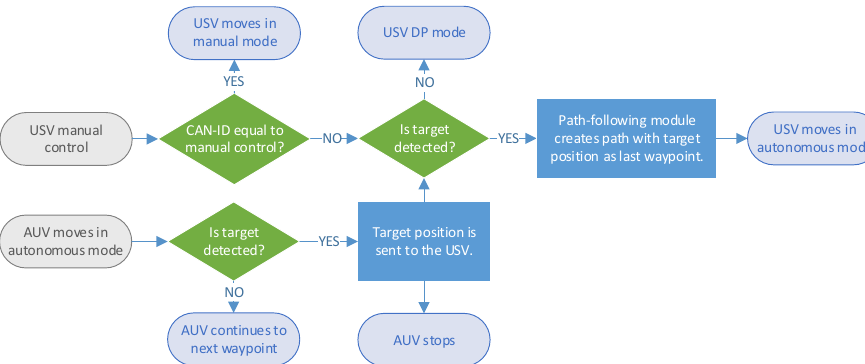
Figure 9. Stateflow diagram for priority control level in the multi-vehicle guidance system. The target detection algorithm at the AUV enables the autonomous operation of the